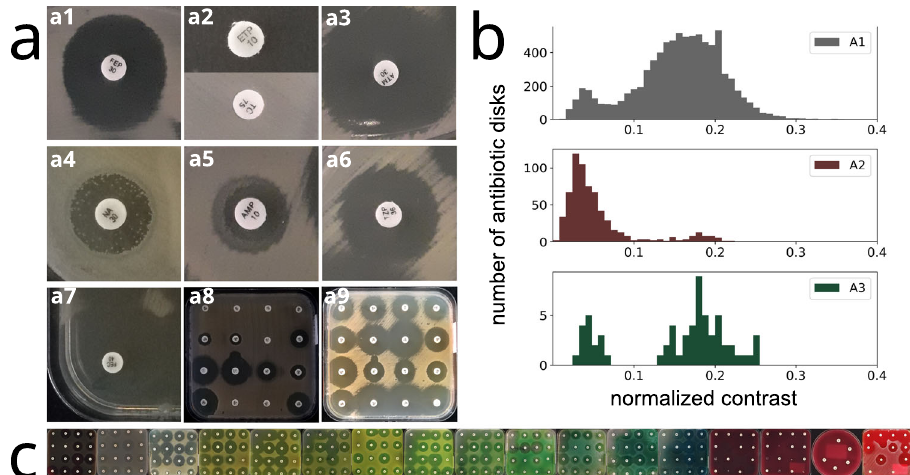
Fig. 6 Variability in antibiogram pictures. Examples of dif fi cult cases for diameter reading ( a ). Non-circular inhibition shape (a1). Total or no inhibition (a1). Light re fl ections (a3). Colonies within the zone of inhibition (a4). Double inhibition zones (a5). Hazy borders (a6). Inhibition zone overlap and plate borders (a7). Low contrast (a8) de fi ned as the difference between the inhibition and bacteria intensity value, compared to a high contrast (a9) image observed in dataset A1. The histograms in ( b ) show the contrast variability observed in the benchmark datasets (contrast is de fi ned as the difference between the central gray levels of bacteria and inhibition, and normalized to the maximum available gray level). Observed variability in dominant hue ( c ).